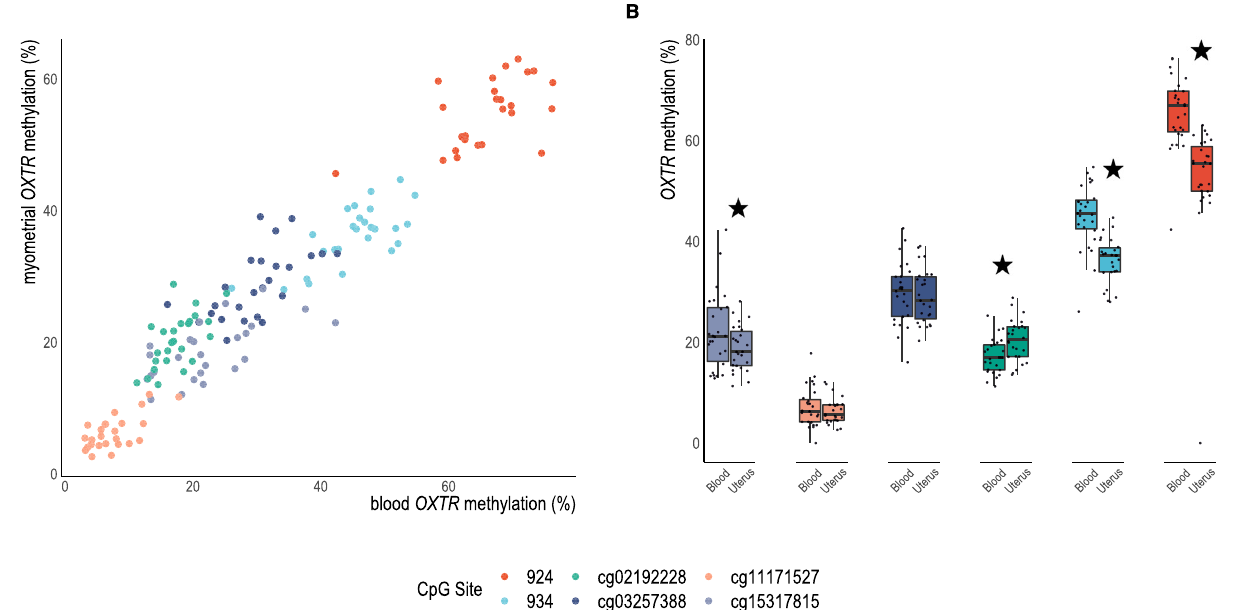
Fig. 2 DNA methylation of CpG sites in OXTR are correlated in blood and myometrium. A Signi fi cantly correlated CpGs between tissues ( n = 26 participants with matched samples) p < 0.05 after correction for multiple comparisons using the Benjamini-Hochberg method: − 924 (red): ρ = 0.52, p = 0.03, − 934 (light blue): ρ = 0.65, p = 0.005, cg02192228 (green): ρ = 0.62, p = 0.001, cg03257388 (dark blue): ρ = 0.66, p = 0.005, cg11171527 (apricot): ρ = 0.55, p = 0.02, cg15317815 (lavender): ρ = 0.59, p = 0.01. B Differences in methylation levels at each CpG site between myometrium and blood, stars denote Bonferroni corrected signi fi cant differences: − 934 (t(25) = 10.1, p = <0.001), − 924 (t(25) = 9.6, p < 0.001), cg15317815 (t(24) = 3.2, p = 0.004), cg02192228 (t(24) = − 4.3, p = 0.003), cg03257388 (t(24) = 1.12, p = 0.27), cg11171527 (t(24) = 2.2, p = 0.04). Whiskers denote + / − 1.5 x interquartile